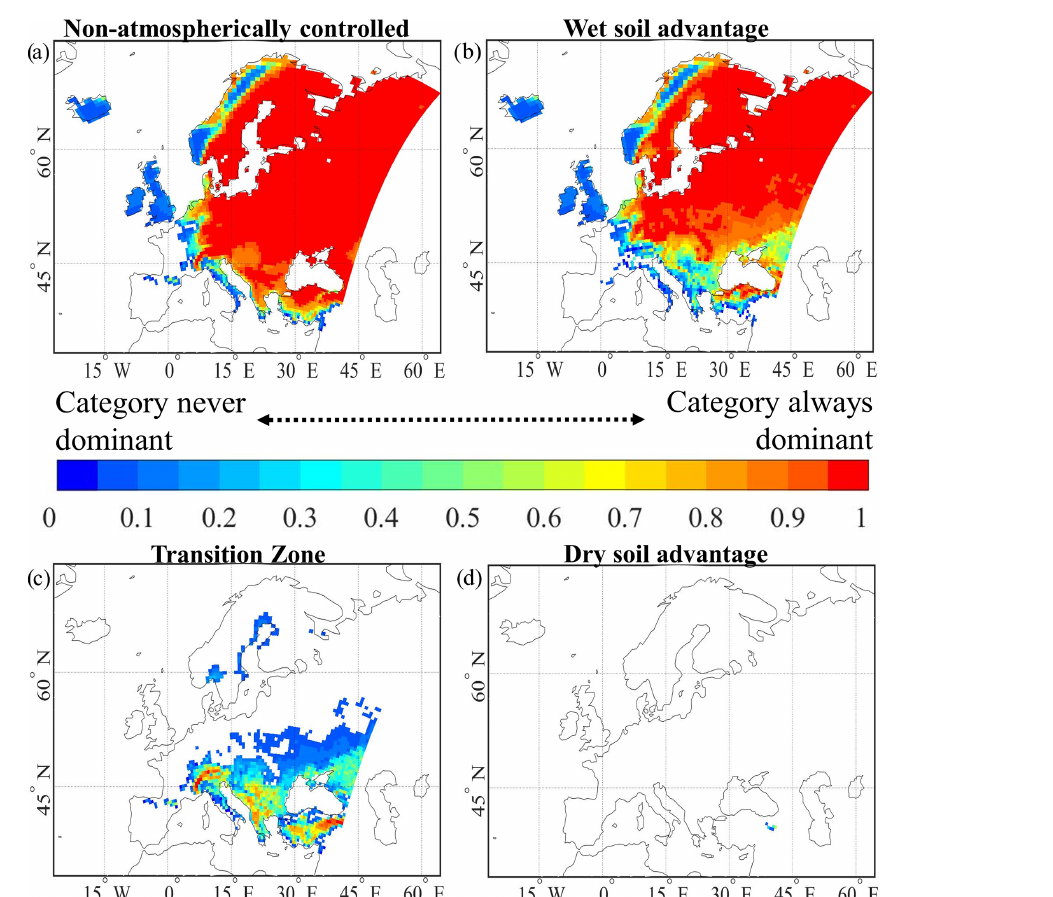
Figure 13. Sensitivity of coupling classes of (a) any coupling class, (b) classified as wet soil advantage level 1 or level 2, (c) classified as transition zone level 1 or level 2, and (d) classified as dry soil advantage level 1 or level